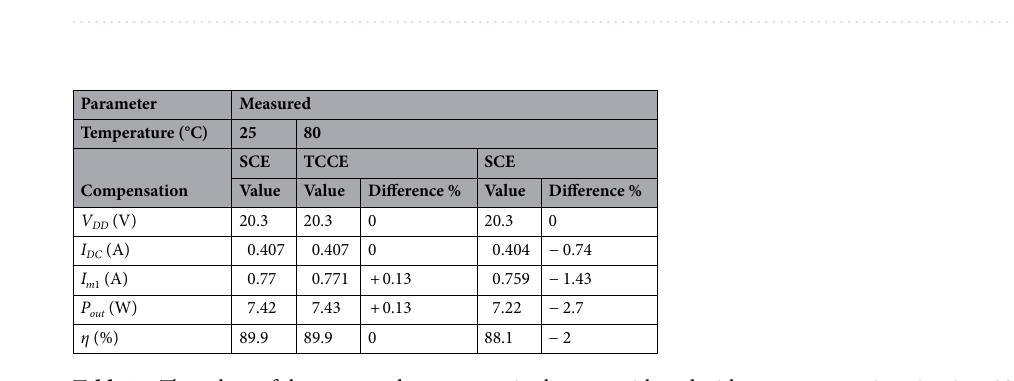
Figure 24. ( a ) The SCE and TCCE output driver voltage is applied to the transistor gate. ( b ) The SCE and TCCE waveform of V d and ( c ) The SCE and TCCE output voltage for the simulation, theoretical, and fabrication at 25 °C and 80 °C.